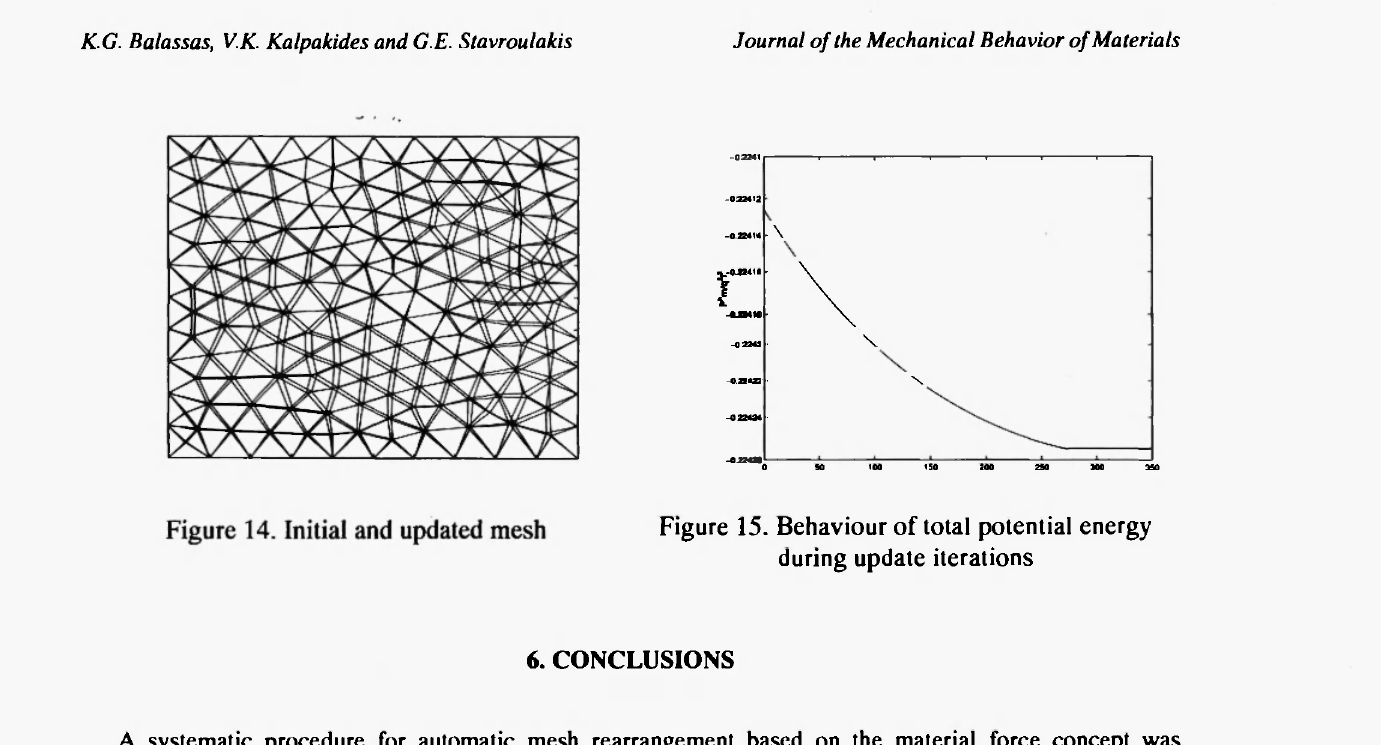
Figure 15. Behaviour of total potential energy during update